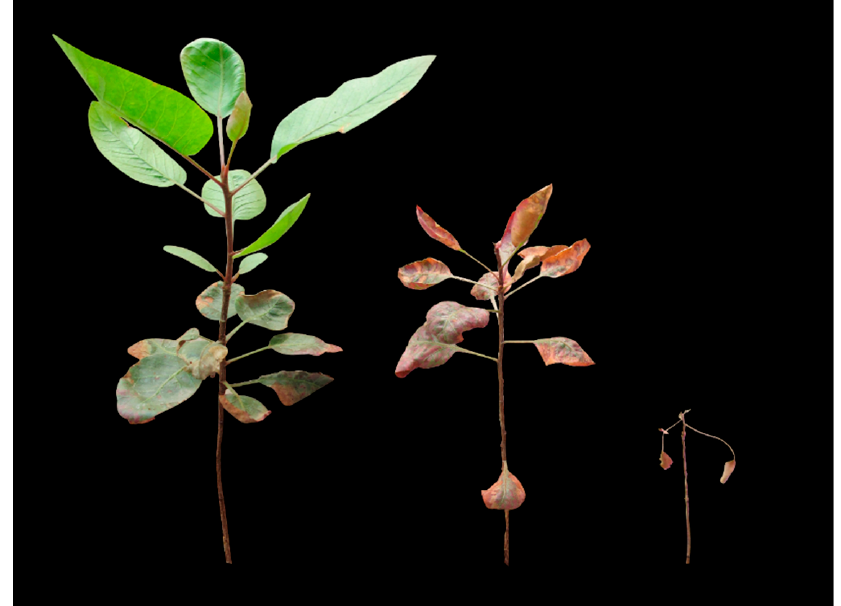
Figure 1. Appearance of the pistachio rootstocks treated with 200 mM NaCl for 90 days. ‘Ghazvini’ (Left), as the most tolerant rootstock, had higher growth and leaf area, followed by ‘Ghermez-Pesteh’ (Middle) and ‘Mutica’ (Right).